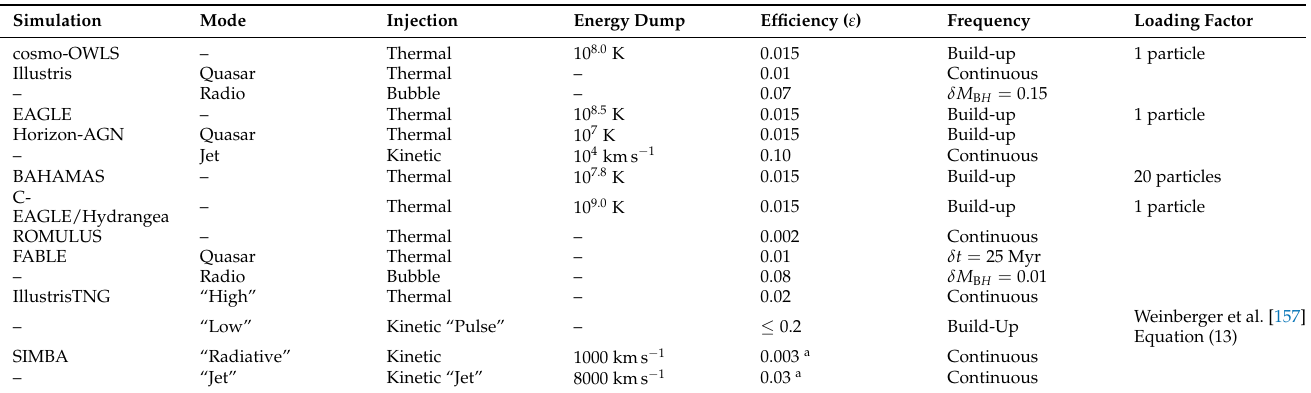
Table 2. AGN feedback modules used in